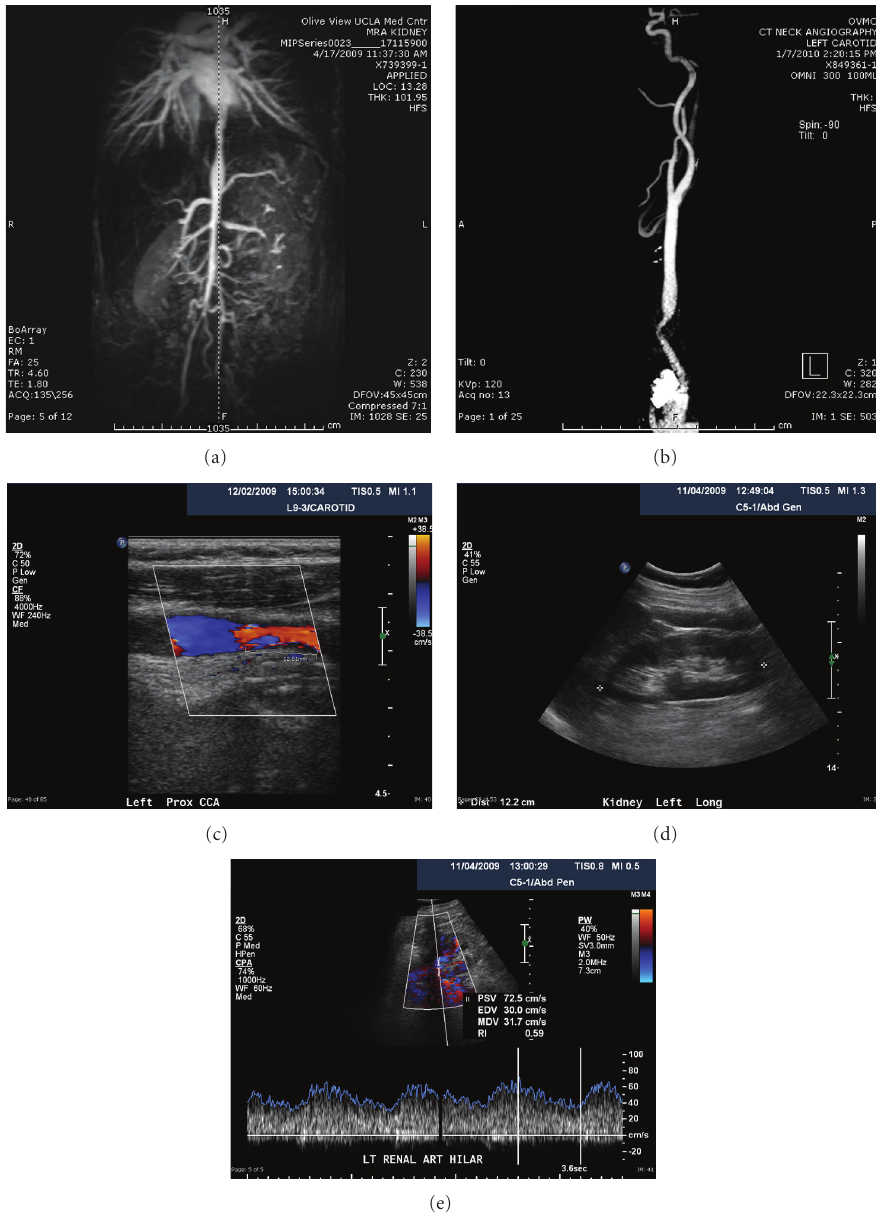
Figure 2: images of patient Y.P. and Takayasu’s arteritis (a) Patient Y.P. MRA of abdomen and pelvis from 04/01/2009. 3D angiogram showing thoracic aortic stenosis at the level of the descending aorta and abdominal aortic stenosis. Stenosis of the left renal artery is also